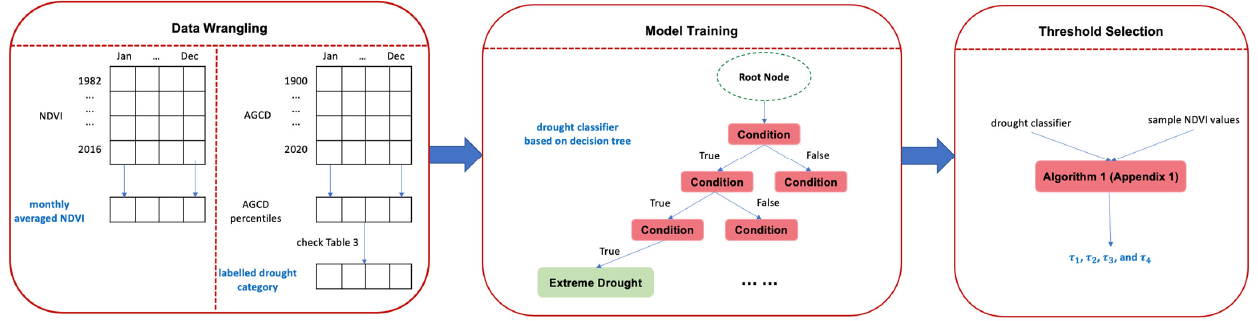
Figure 2. The framework of our solution. The blue texts in bold denote the output in the current phase.